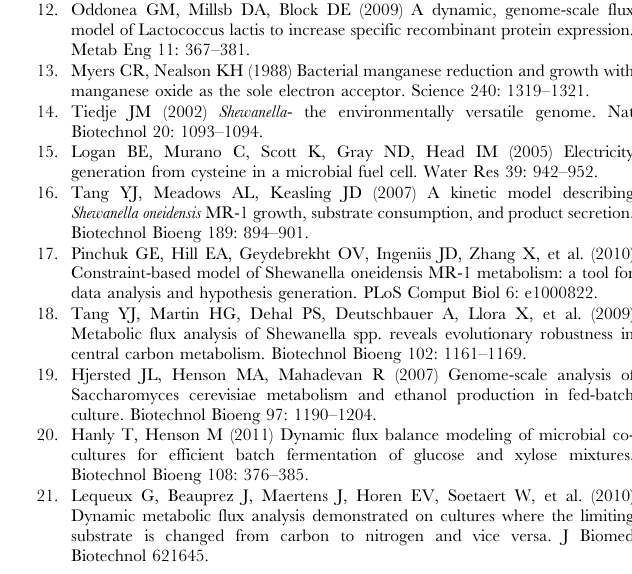
Figure S3 Histogram of normalized Monod model residuals. Table S1 Lack-of-fit test for the Monod model. Text S1 Framework of integrative Flux Balance Analysis (iFBA). Text S2 Reactions involved in 13 C-labeling simulations. Text S3 SBML file of the metabolic model for